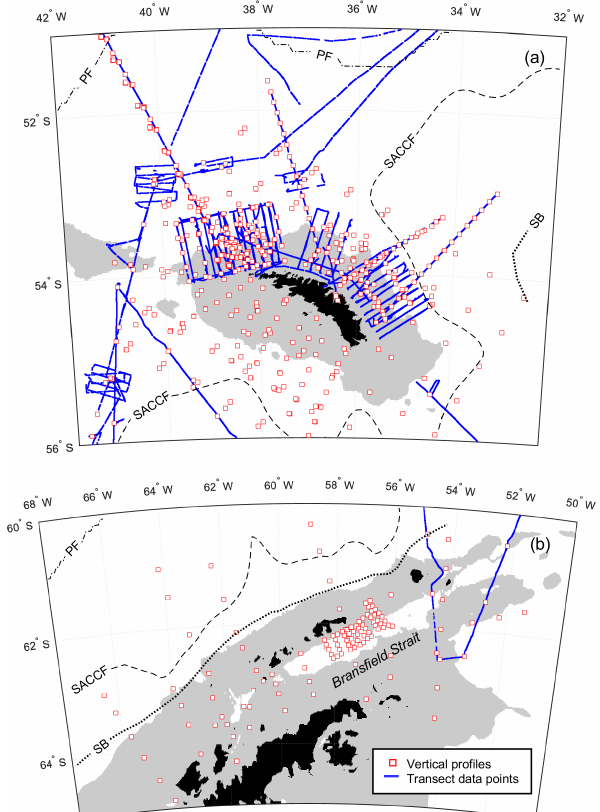
Figure 2. Smaller-scale detail of sampling around (a) South Geor- gia. (b) Antarctic Peninsula. Southern Ocean fronts, pale grey areas and coastline are as in Fig. 1.